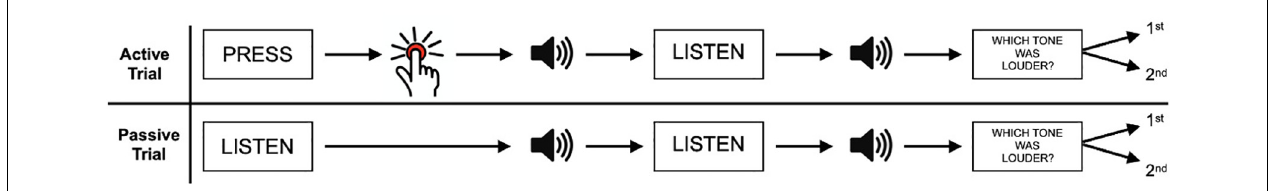
FIGURE 1 | A typical experimental setup examining sensory attenuation in the auditory paradigm. In active trials, participants have to self-initiate a sound (e.g., through a button press) and compare its volume to an externally generated sound. In passive trials, both sounds are generated externally. Adapted from Reznik et al. (2015). Copyright (2015) by Reznik et